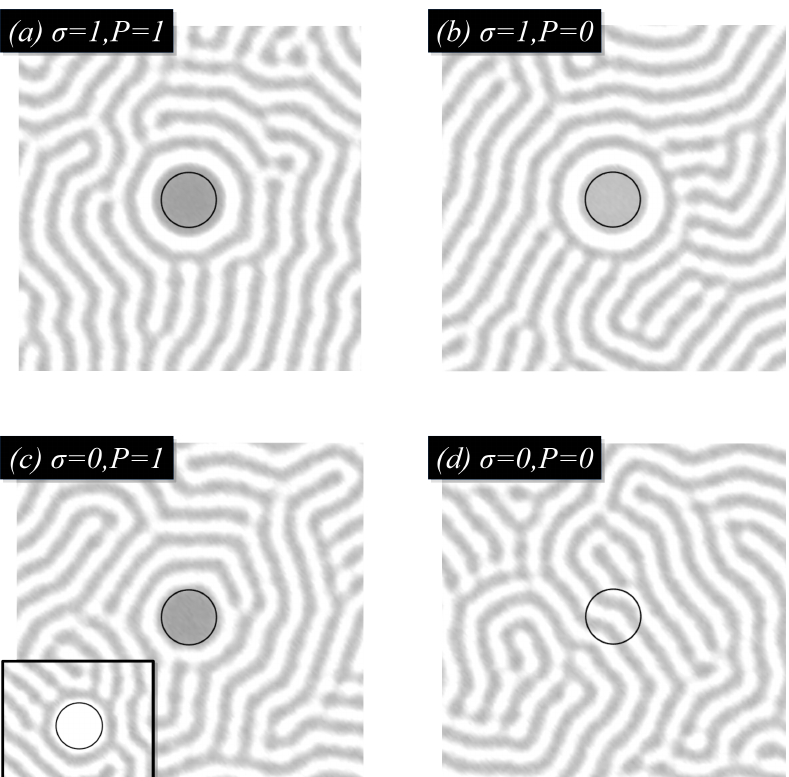
Figure 4. Single selective particle ψ 0 = − 1 within a lamellar-forming BCP ( f 0 = 1/2) under various conditions for the particle–polymer